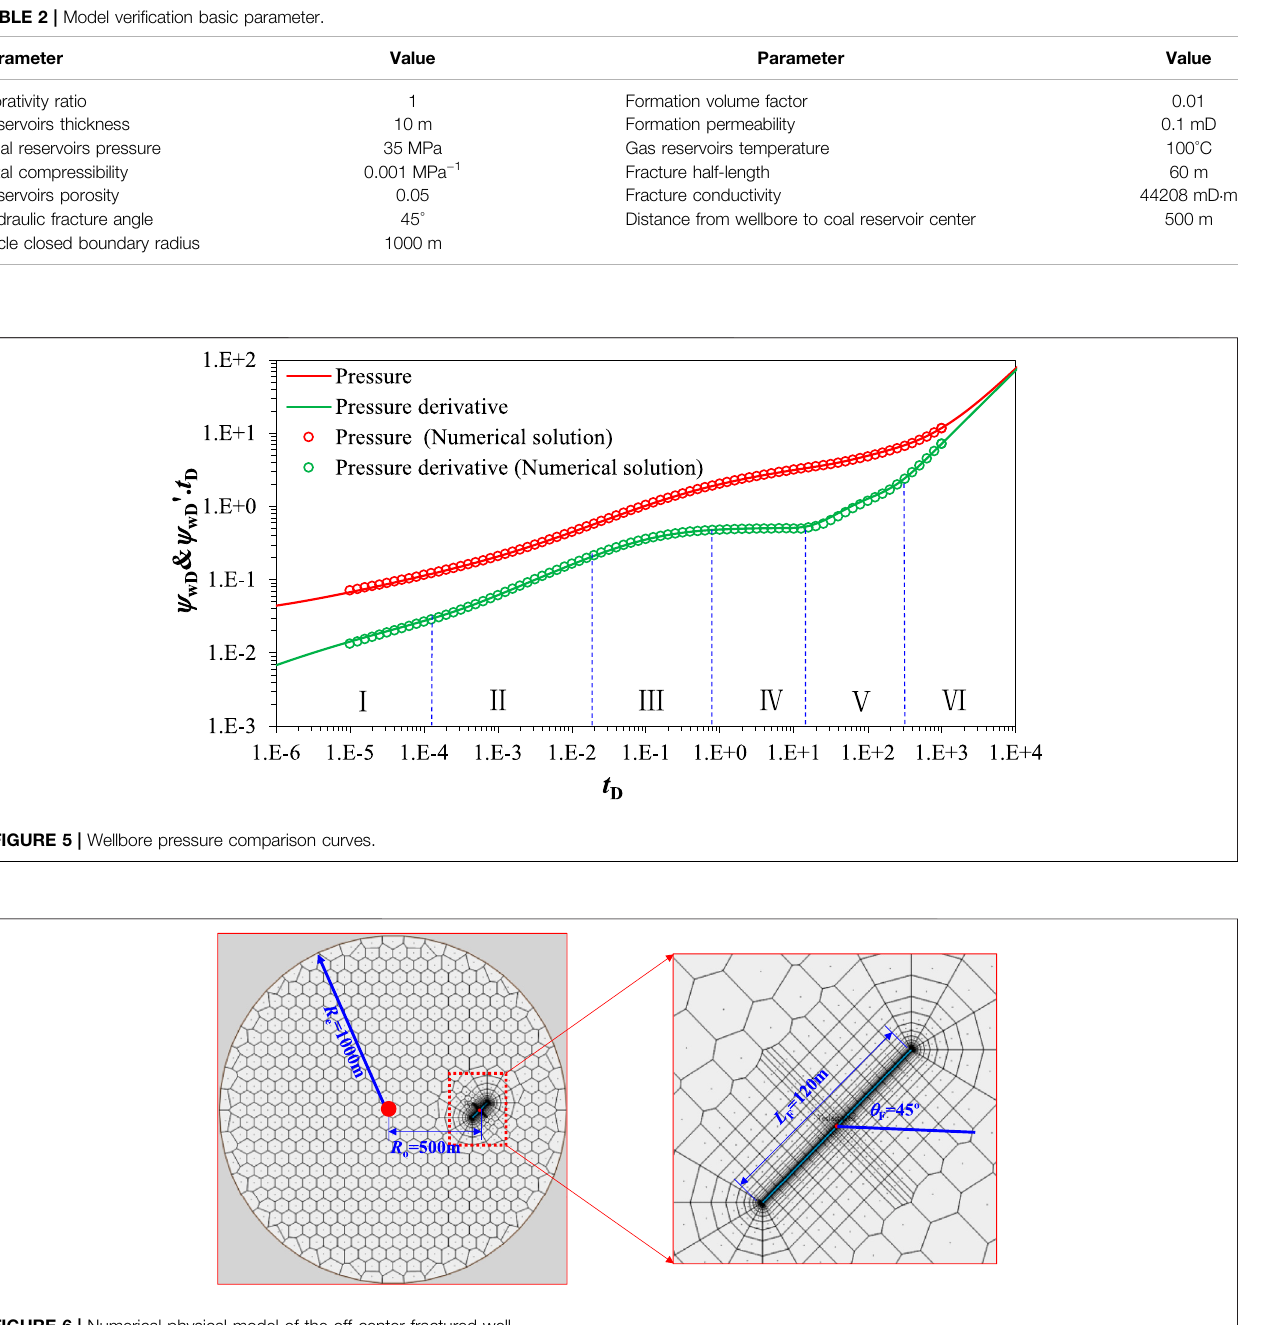
FIGURE 6 | Numerical physical model of the off-center fractured